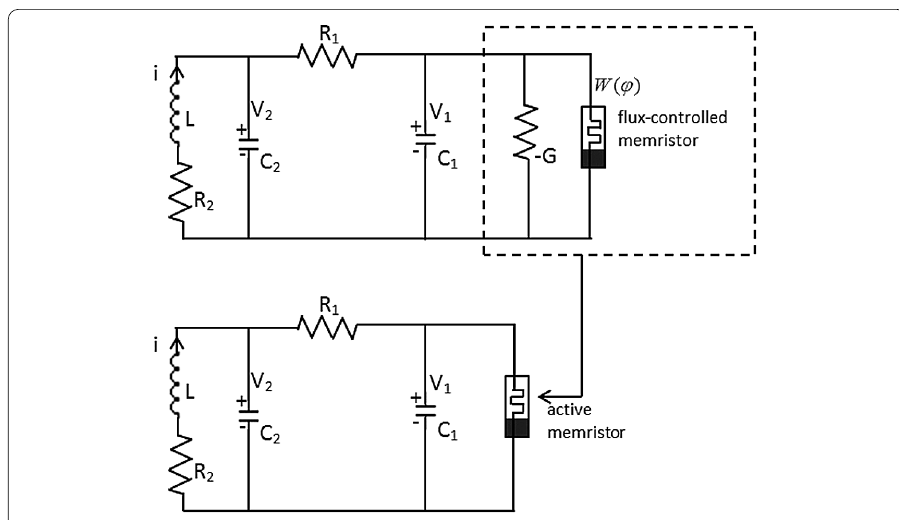
Figure 1 Memristor-based hyperchaotic